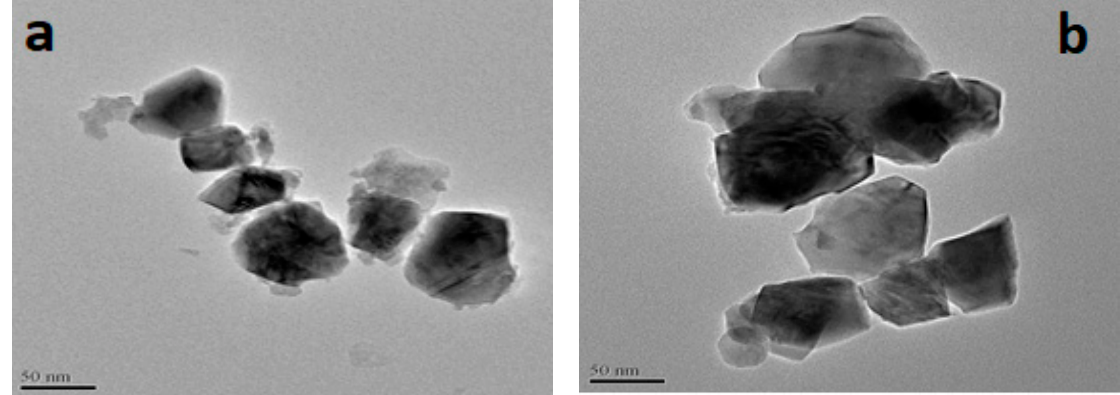
Figure A4. TEM image of ( a ) Al 2 O 3 NPs and ( b ) SiO 2 NPs. The energy dispersive X-ray analysis (Figure A5) confirms the purity of the metal oxides. The presence of the respective metal and oxygen elements only in the alumina and silica samples, as shown in Figure A5a,b suggests that there is no contamination.